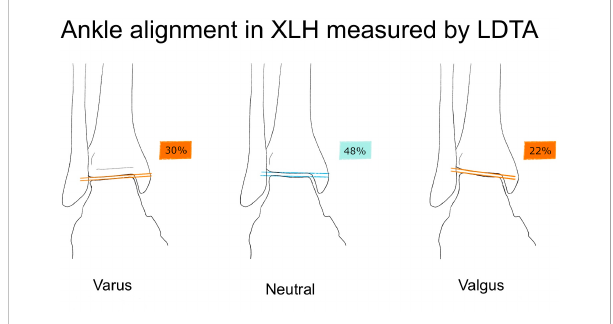
FIGURE 3 Illustration of the lateral distal tibial angle (LDTA) and ankle alignment in XLH patients (n = 46 limbs), norm values from Paley (11). Normal ankle alignment was de fi ned as LDTA between 86 and 92